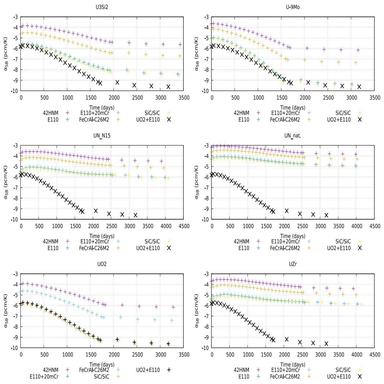
Boron concentration reactivity feedbacks of chosen fuel-cladding combinations.